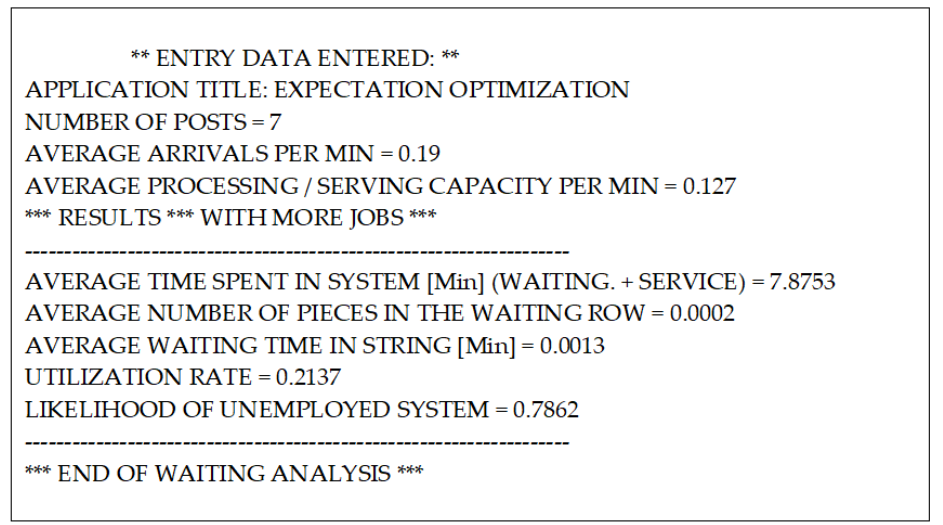
Figure 6. The results for the PP7 queueing system.